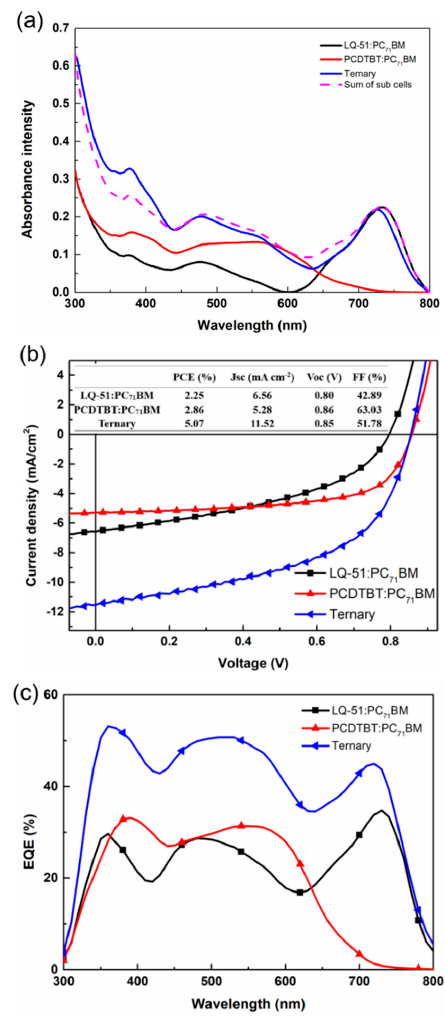
Figure 4. Properties of the ternary device and “sub-cells”. ( a ) The absorption spectra of LQ-51/PCDTBT/PC 71 BM (~117 nm), LQ-51/PC 71 BM (~60 nm), and PCDTBT/PC 71 BM (~55 nm) blend films; ( b ) The J–V characteristics of the ternary device and “sub-cells”; ( c ) EQE curves of the ternary device and “sub-cells”.